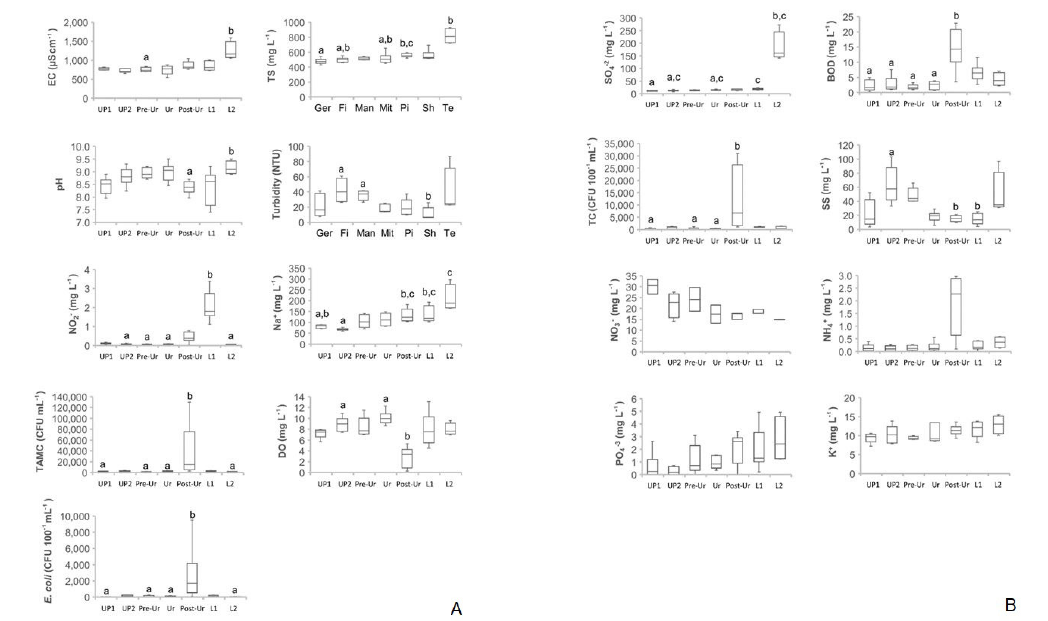
Figure 4. (A and B). Boxplots for physicochemical and microbiological variables at seven reaches along the Del Azul stream. Reaches are consecutively ordered from the upper to the lower basin. Different letters above the error bars indicate statistical significance (p<0.05). Please refer to the main text for reach acronyms